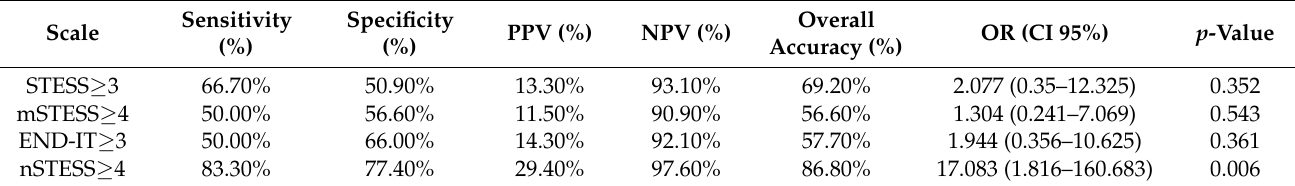
Table 3. Capacity of the new scale (nSTESS) versus the STESS, mSTESS, and END-IT to predict mortality. Scale